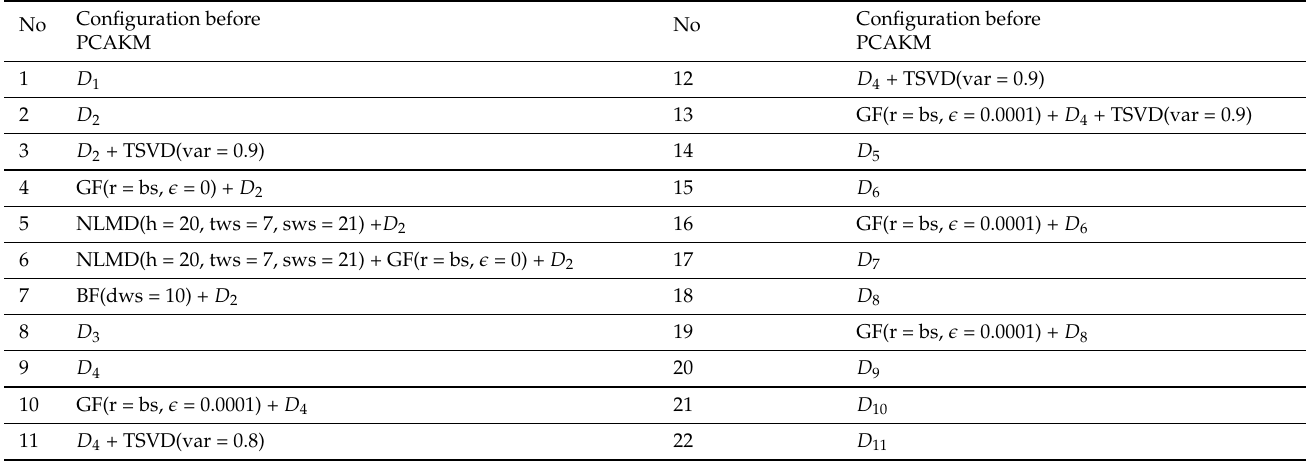
Table 3. Configurations.